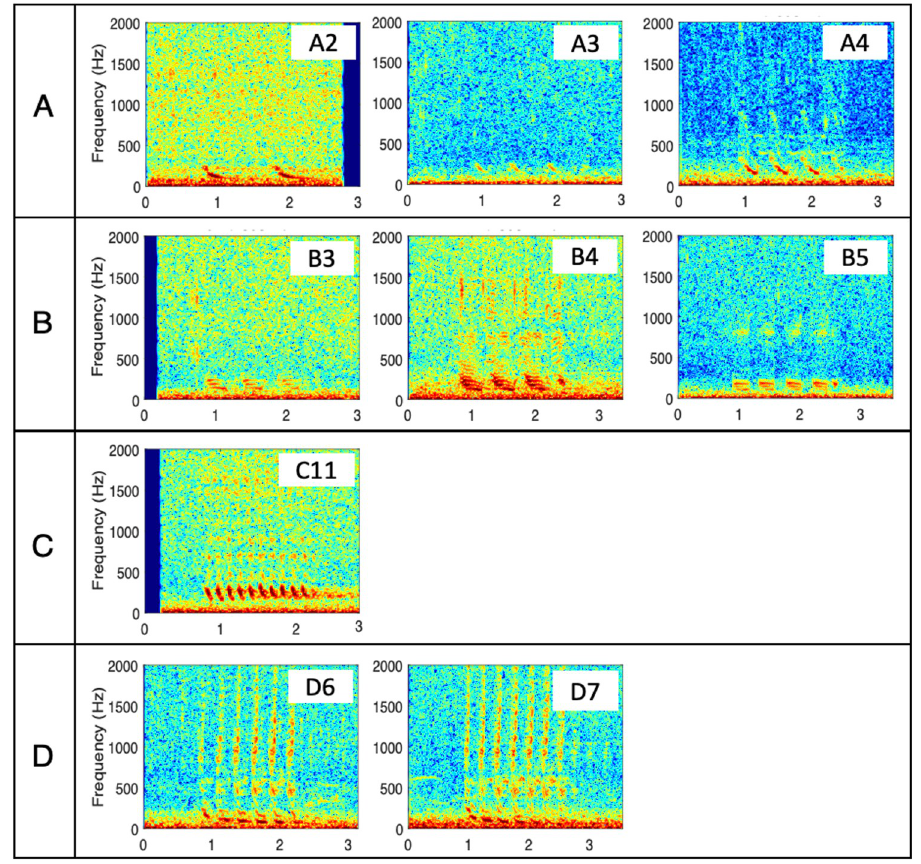
Fig 3. Spectrograms of different Bio-duck calls of the Antarctic minke whale detected in the Santos Basin, Brazilian offshore waters. FFT = 512, overlap = 95%, Time expressed in seconds and frequency scale in Hz.